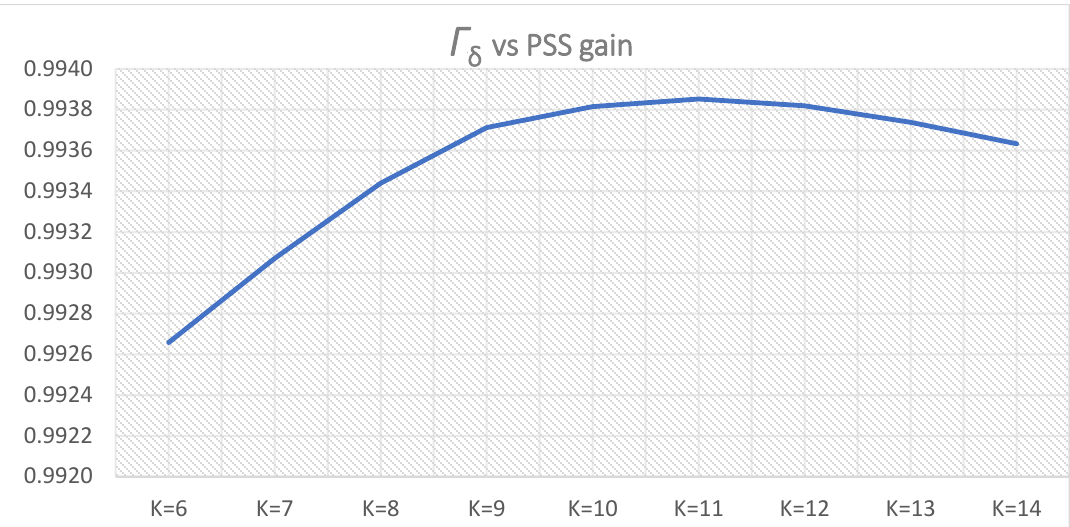
Figure 20. Γ ω ( Γ ωi,l 1 and Γ ωi,u 1 from Table 7 and Table 8) for PSS parameters T = 0.5 s, K = 6 – 14.